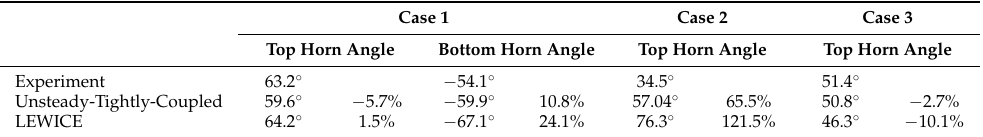
Table 6. Horn angle of the SSD